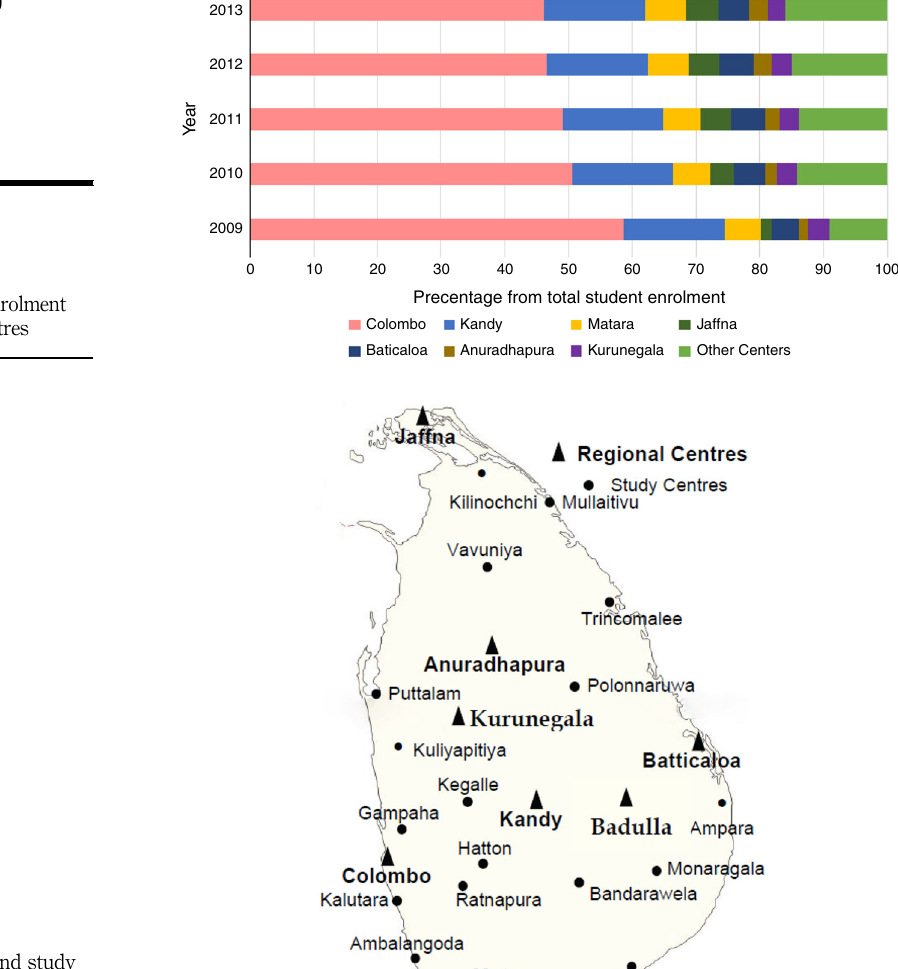
Figure 3. Student enrolment